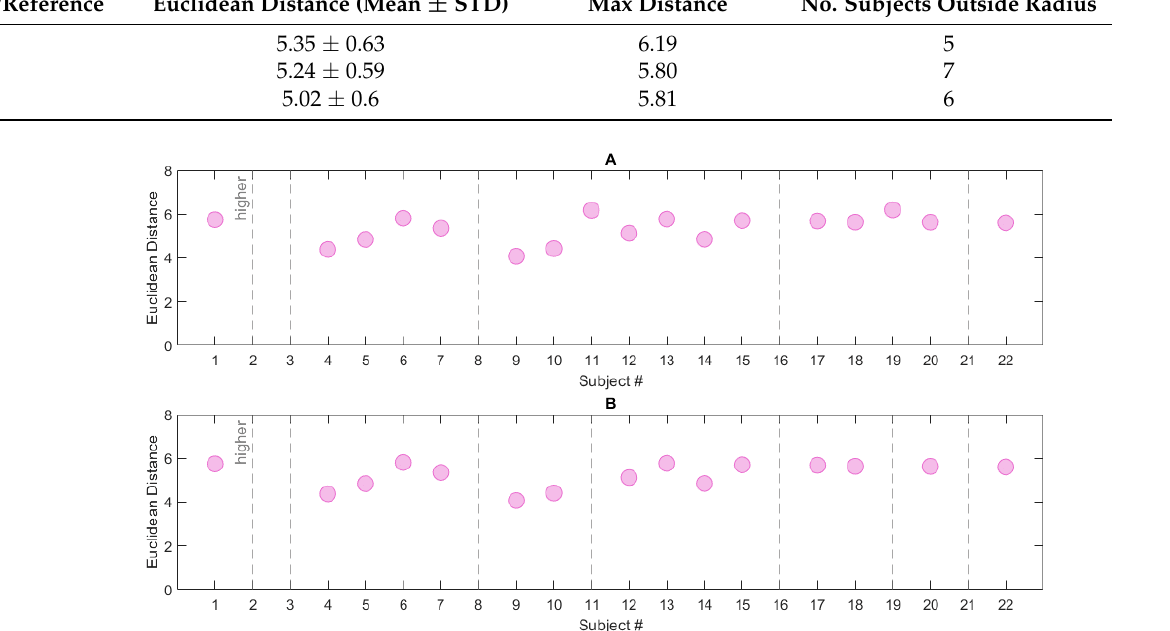
Figure 10. Euclidean Distance computed for the RBD subjects in the CAP Sleep Database. Two neighbourhood/reference combinations are reported: ( A ) R 1 /S 1 , ( B ) R 2 /S 2 . The grey dashed lines represent subjects located outside the neighbourhoods (i.e., subjects whose Euclidean Distance from the chosen reference is higher than the neighbourhood